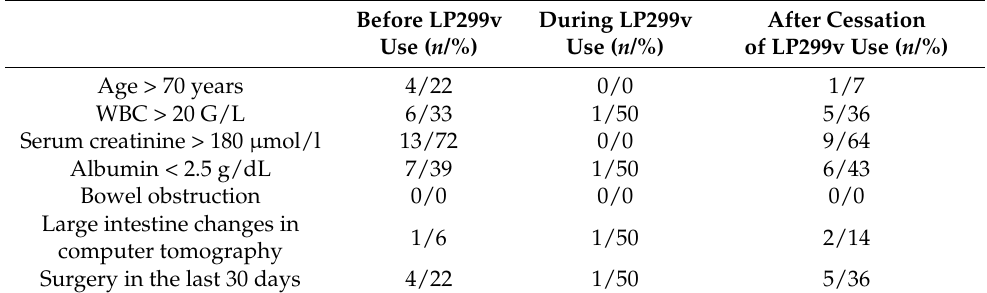
Table 6. Risk factors of severe CDI in periods before, during and after cessation of LP299v administration ( n = 34). The above-mentioned periods lasted twelve